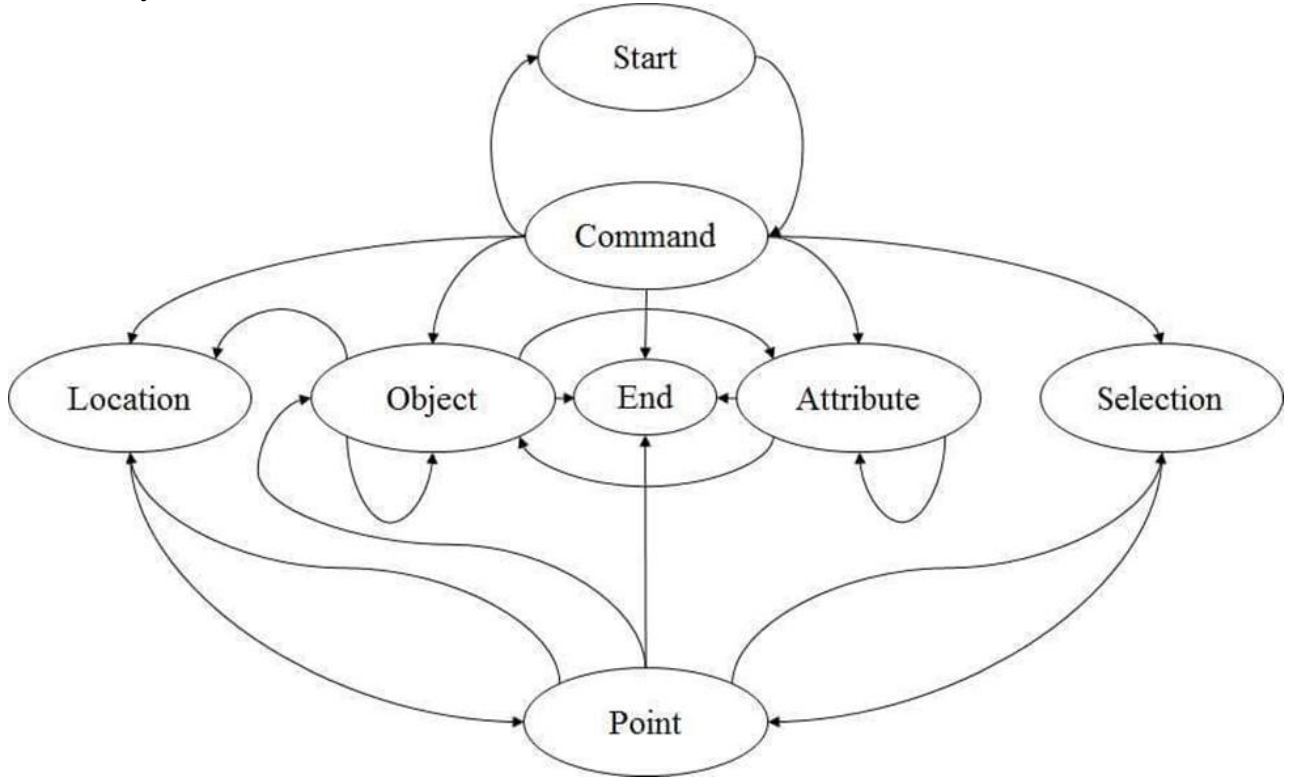
Figure 4: Framework’s Description